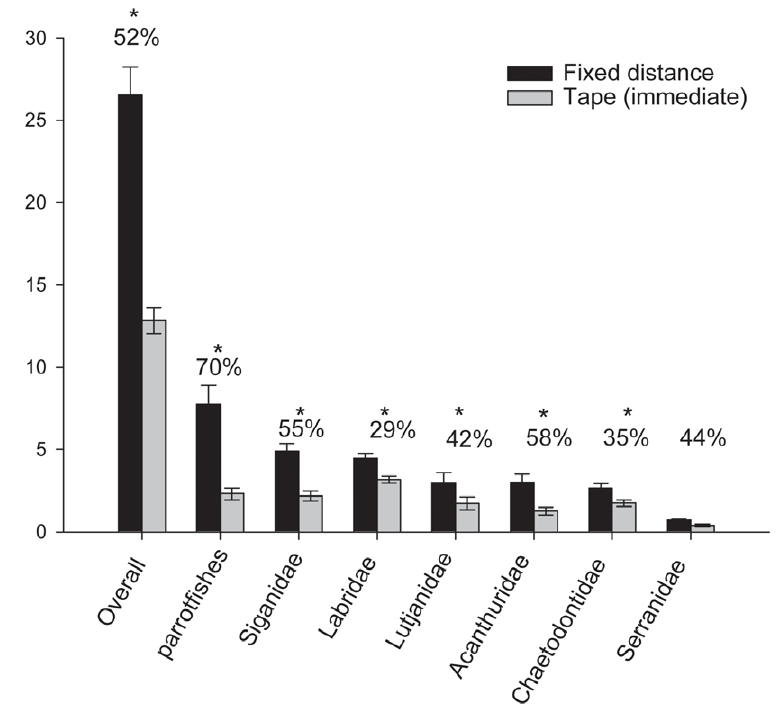
Figure 1. Relative diver effects – fixed distance and immediate return. Relative diver effects on estimated reef fish densities comparing counts over a fixed distance 50 m transect and counts along the tape immediately after deployment. Values indicate the proportional decrease in abundance; asterisks represent significant differences using a Bonferroni corrected alpha-value ( p , 0.006). The parrotfishes formerly in the family Scaridae are now a distinct lineage within in Labridae [56].